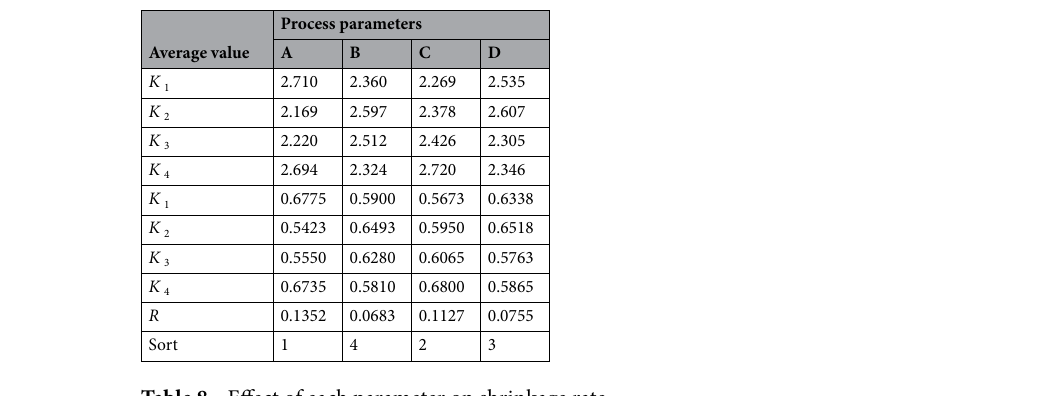
Table 8. Effect of each parameter on shrinkage rate.